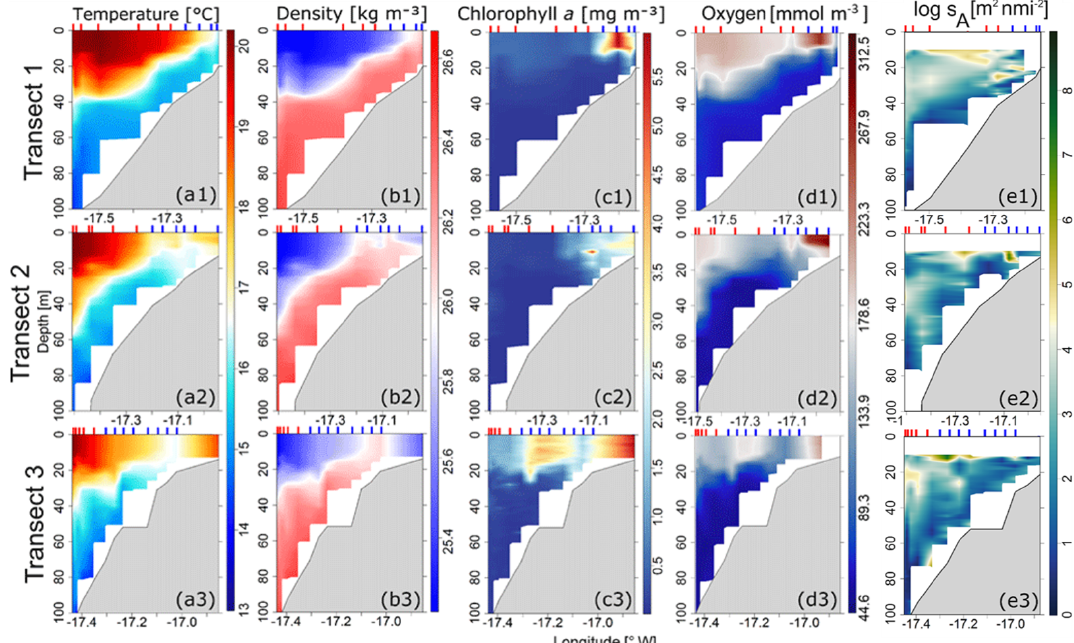
Figure 4. Contour plots of (a) temperature, (b) density, (c) chlorophyll- a concentration, (d) dissolved oxygen, and (e) square rooted nautical area scattering coefficient ( s A ) in the three transects (T1, T2, T3; see Fig. 1) with positions of vertical probe stations CTD in the inshore area (vertical line in blue (G1)) and the offshore area (vertical line in red (G2)).